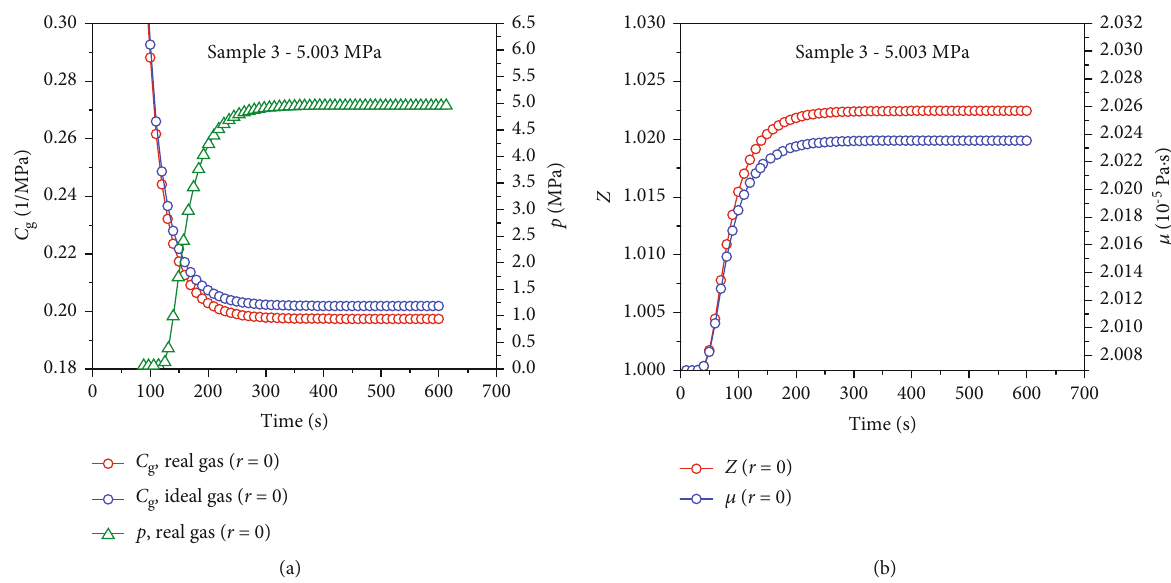
Figure 9: The variation of real gas pressure with time (a), and the corresponding variations of real and ideal compressibility factors (a), real deviation factor, and real viscosity (b) at 5.003 MPa and 303.15K, with Sample